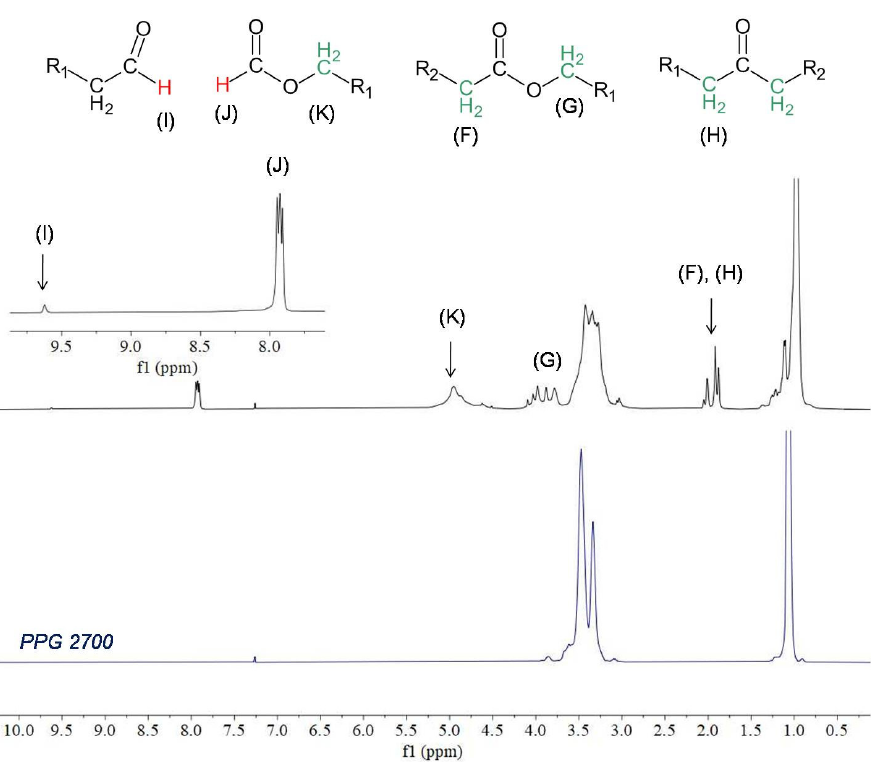
Figure 7. 1 H NMR spectra (CDCl 3 , 400 MHz) of raw PPG2700 (blue) and PPG2700 exposed to UV radiation (black). Inset: enlarged region within the 7.5–10 ppm spectral range after UV exposure.